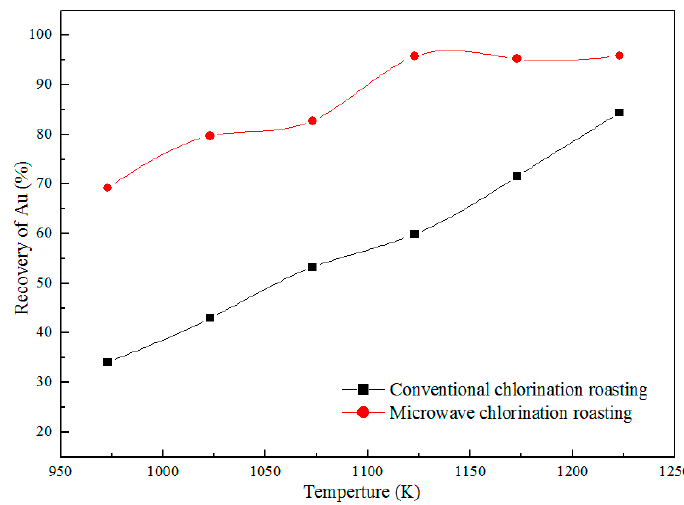
Figure 4. Effect of different temperatures on the recovery of Au.